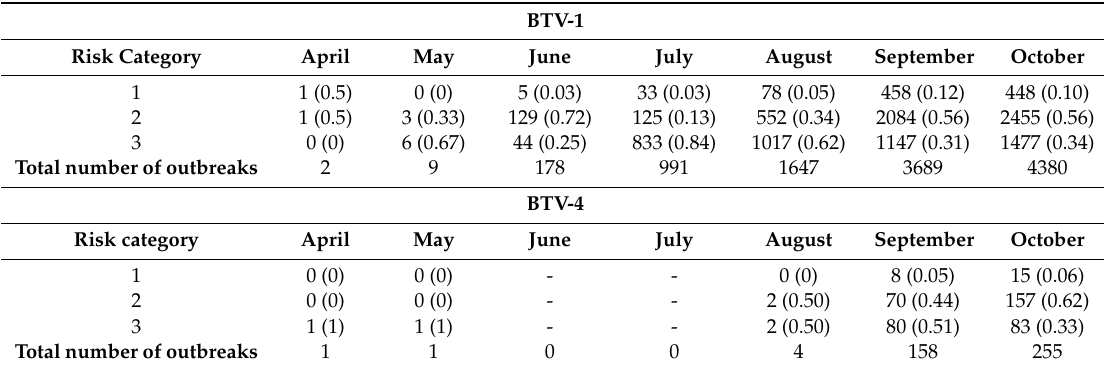
Table 2. External assessment of the bluetongue virus (BTV) transmission risk maps using BTV-1 (2007–2017) and BTV-4 (2010–2018) historical data from the European Animal Disease Notification System (ADNS) database according to the estimated date of infection. The number and decimal fraction of the outbreaks that fall into the di ff erent risk categories is shown.